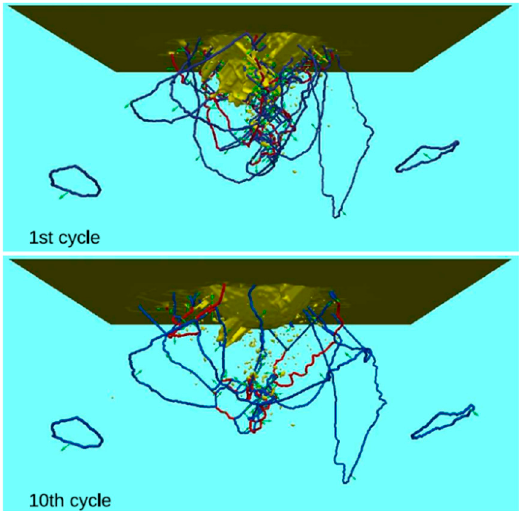
Figure 7. Snapshots of the dislocation network after (top) the first and (bottom) tenth indentations. Yellow: deformed surface and other unidentified defects. Dislocations are colored according to their Burgers vector b : blue ½ <111>, red <100>.